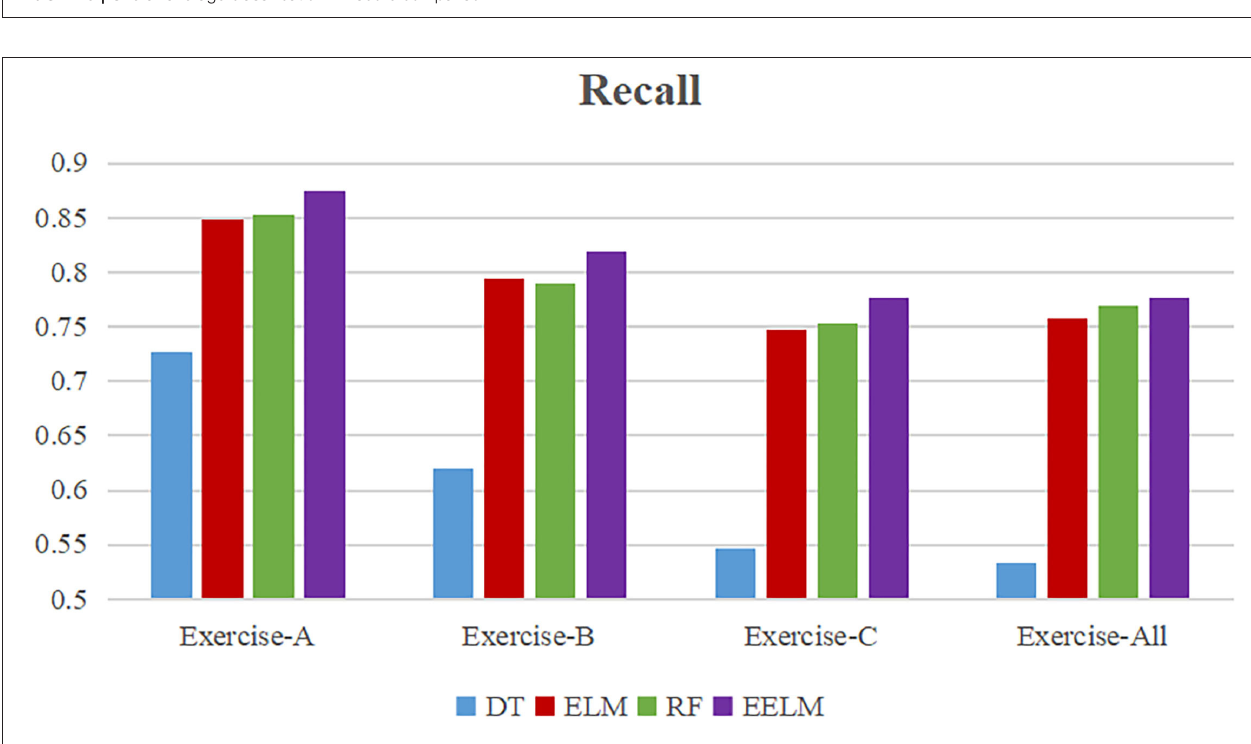
FIGURE 9 | Overall average classification F1-score comparison.